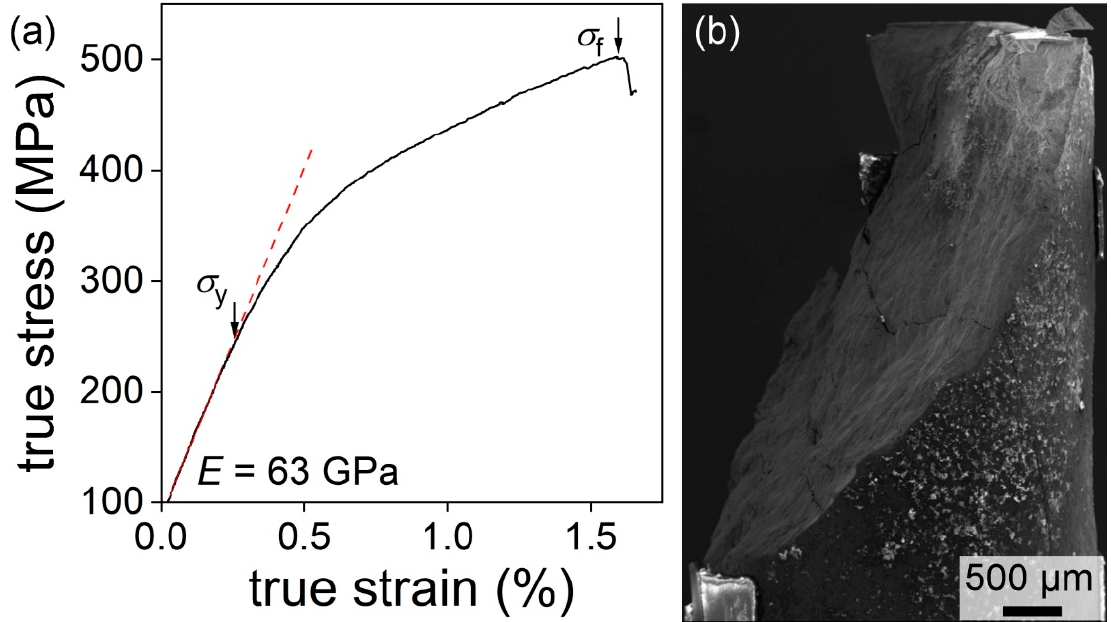
Figure 5. Characteristics of rapidly solidified Mg 67 Ag 33 subjected to uniaxial compression. ( a ) True stress–strain curve with indicated Young’s modulus, E , yield strength, σ y , and fracture strength, σ f . ( b ) SEM image of a fractured specimen. No barreling was observed.